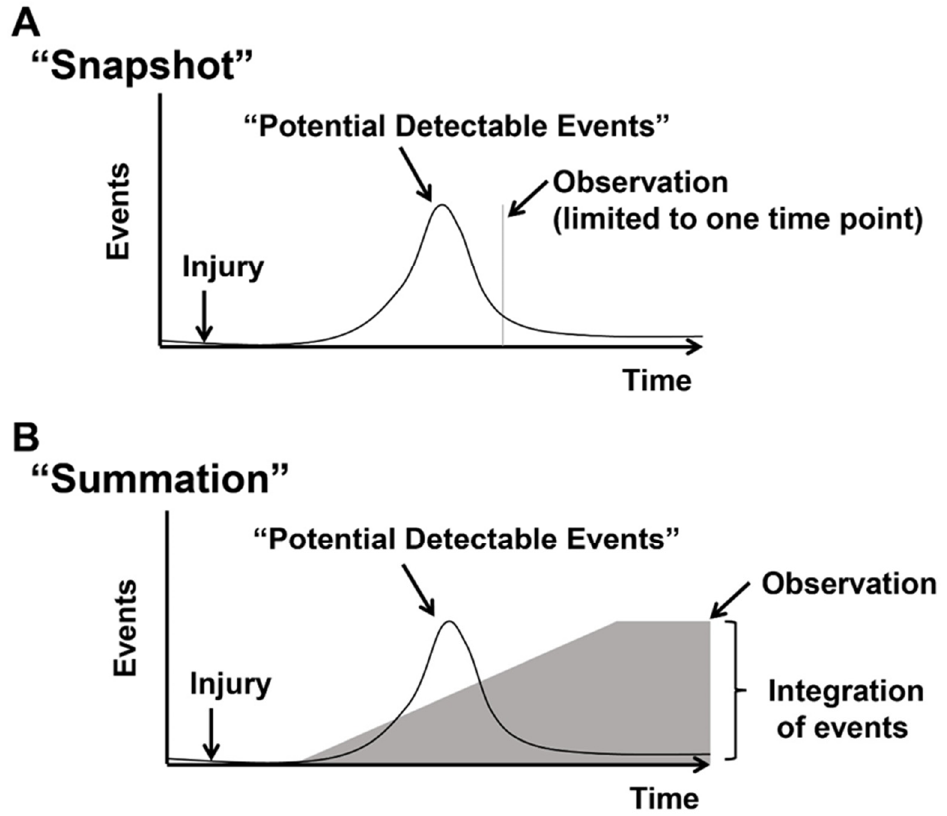
Figure 2. Detecting “Actively cycling” and “Previously cycled” cells. Events represent cycling cells. After an injury, there is an increase and decrease in cycling cells. ( A ) The “snapshot” approach measures cycling events in blue at a distinct time point after the injury. Typically, cycling cells are detected by the co-localization of markers of cycling (Ki67, PH3, Aurora B, and Anillin) with cardiomyocytes or transgenic mice that report phases of the cell cycle (FUCCI, Ki67-RFP, eGFP-Anillin). ( B ) The “summation” approach relies on indelibly marking cycling events and measuring total events after an injury. Cycled cells are labeled by incorporating nucleotide analogs into synthesizing genomic DNA (3H-Thymidine, Bromodeoxyuridine, or 5-Ethynyl-2-deoxyuridine) or transgenic mice that mark cells that cycled or underwent mitosis ( MADM , Confetti/Brainbow, and α DKRC::RLTG ). Figure adapted from Bradley et al., Circ Res 2021, 128, 155–168.